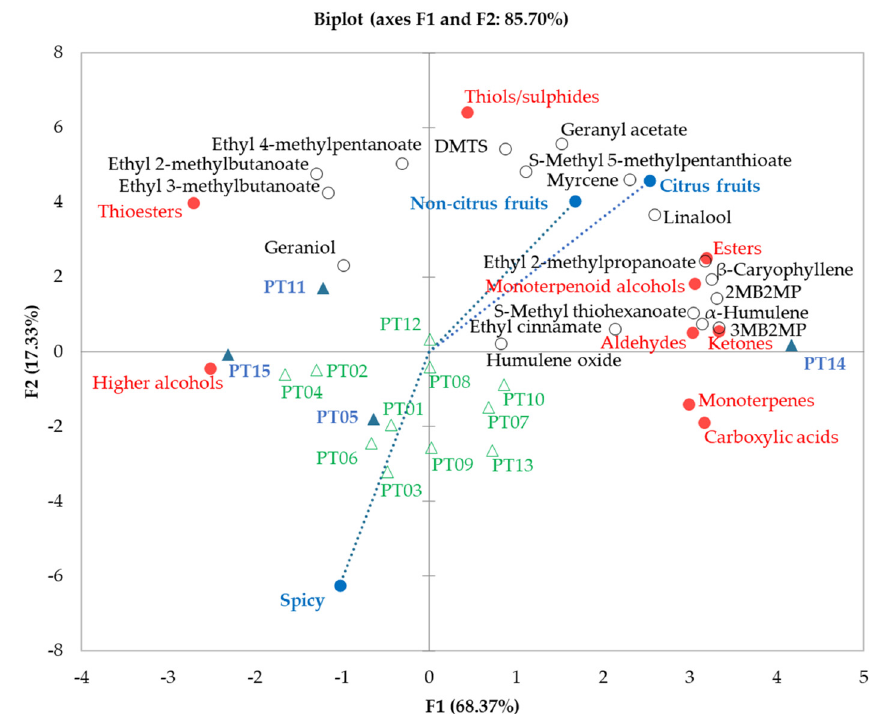
Figure 4. Principal Component Analysis (PCA) biplot using as active variables the olfactometry data (red circles) of the 4 hops (blue triangles), while the sensory attributes (blue circles) and volatile compounds quantified in the dry-hopped beers (open black circles) were used as passive (supplementary) variables and olfactometry data of the other 11 hop samples (open green triangles) were included as supplementary